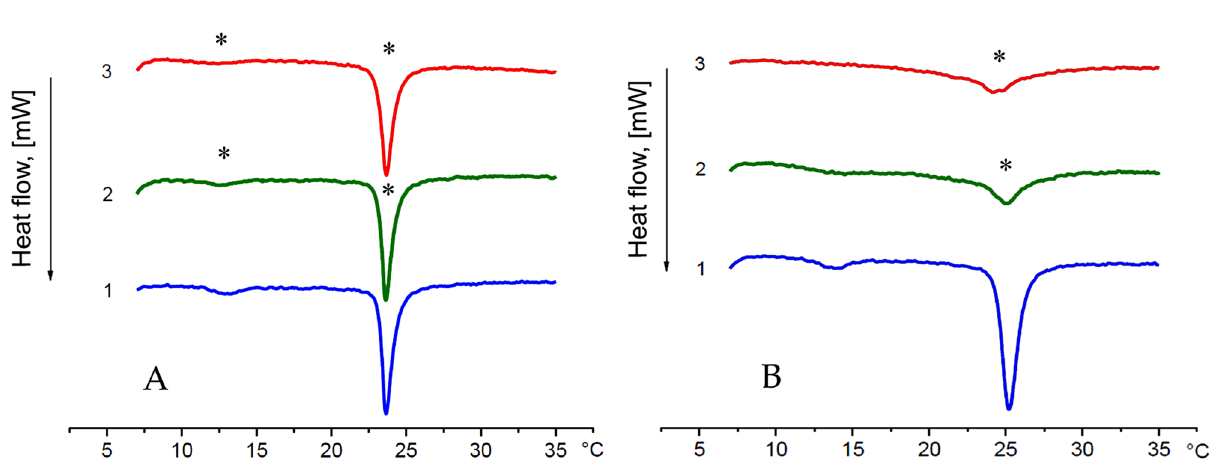
Figure 5. ( A ) DSC heating scans of DMPC membraine in the presence of cationic phosphorus dendrimers G3 complexed with Gp160 HIV-1 peptide (Gp160:G3 1:3, molar). Curve 1 presents the DSC transition of pure DMPC liposomes in absence of dendriplex; 2—in presence of dendriplex at the dendriplex:lipid molar ratio 0.02; 3—dendriplex:lipid molar ratio 0.05. ( B ) DSC heating scans of DMPC:DPPG (9:1, w/w) membrane in the presence of cationic phosphorus dendriplex G3 containing Gp160 (Gp160:G3 1:3, molar). Curve 1 presents the DSC transition of pure DMPC:DPPG liposomes in absence of dendriplex; 2—in presence of dendriplex at the dendriplex:lipid molar ratio 0.02; 3—dendriplex:lipid molar ratio 0.05. Transition peaks with statistically significant (* p < 0.05) areas compered to peaks of membranes without dendriplex